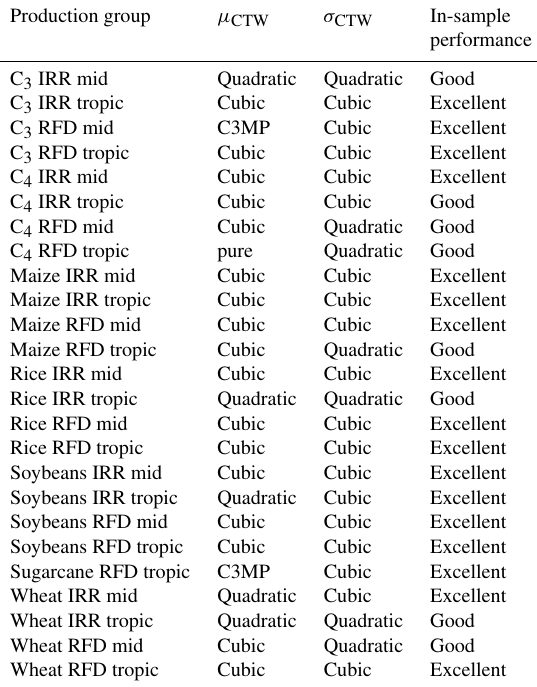
Table A10. The best-performing functional form combination for each production group at the task of leave-one-out cross-validation (out-of-sample performance) and the corresponding in-sample per- formance